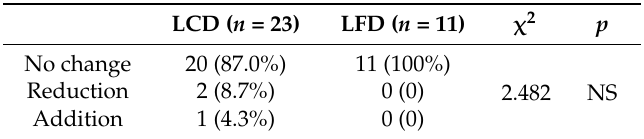
Table 11. Comparison of other antidiabetic drugs between the two groups. LCD ( n = 23) LFD ( n =